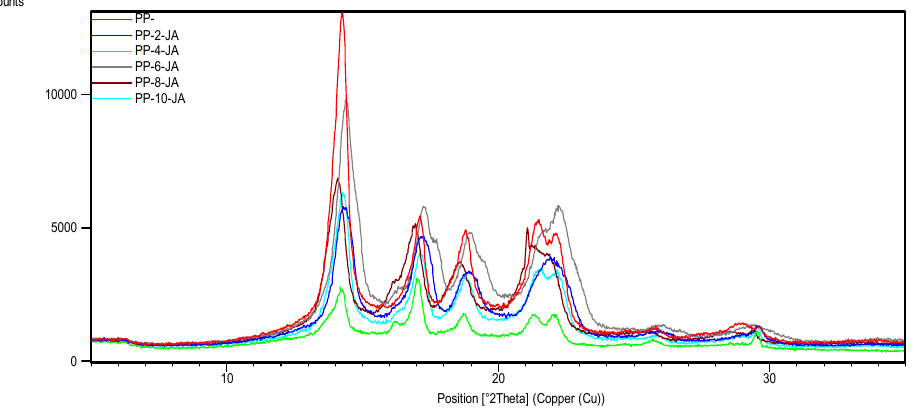
Figure 7. XRD pattern for PP and PP-JA composites.